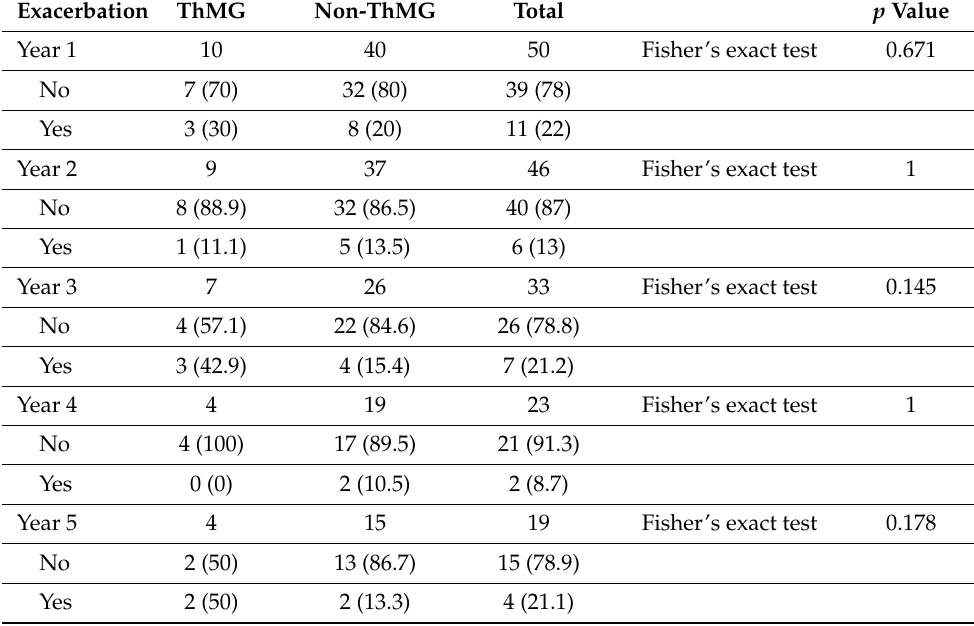
Figure 2. The number of patients distributed in the different levels of post-thymectomy outcomes evaluated by MGFA-PIS in the ThMG and non-ThMG groups during the 5-year follow-ups. Table 6. Comparison of the frequencies of exacerbations after thymectomy between ThMG and non-ThMG patients during the 5-year follow-ups.